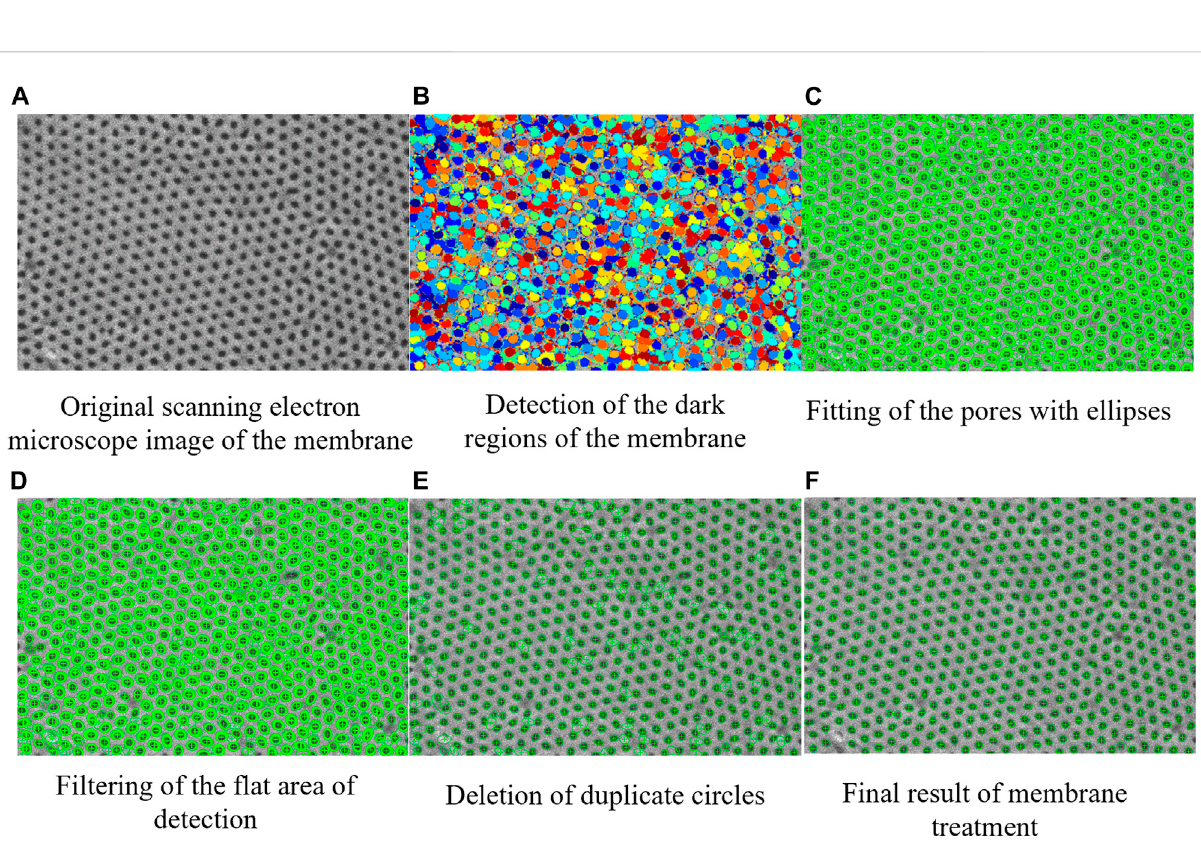
FIGURE 3 Poretreatmentprocessofthemembrane. (A) Originalscanningelectronmicroscopeimageofthemembrane, (B) Detectionofthedarkregions of themembrane, (C) Fitting of thepores with ellipses, (D) Filtering of the fl atarea of detection, (E) Deletion ofduplicate circles, and (F) Final result of membrane